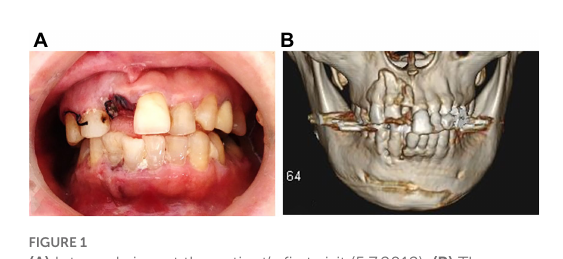
dimensional computed tomography scan obtained before treatment (5.7.2012).